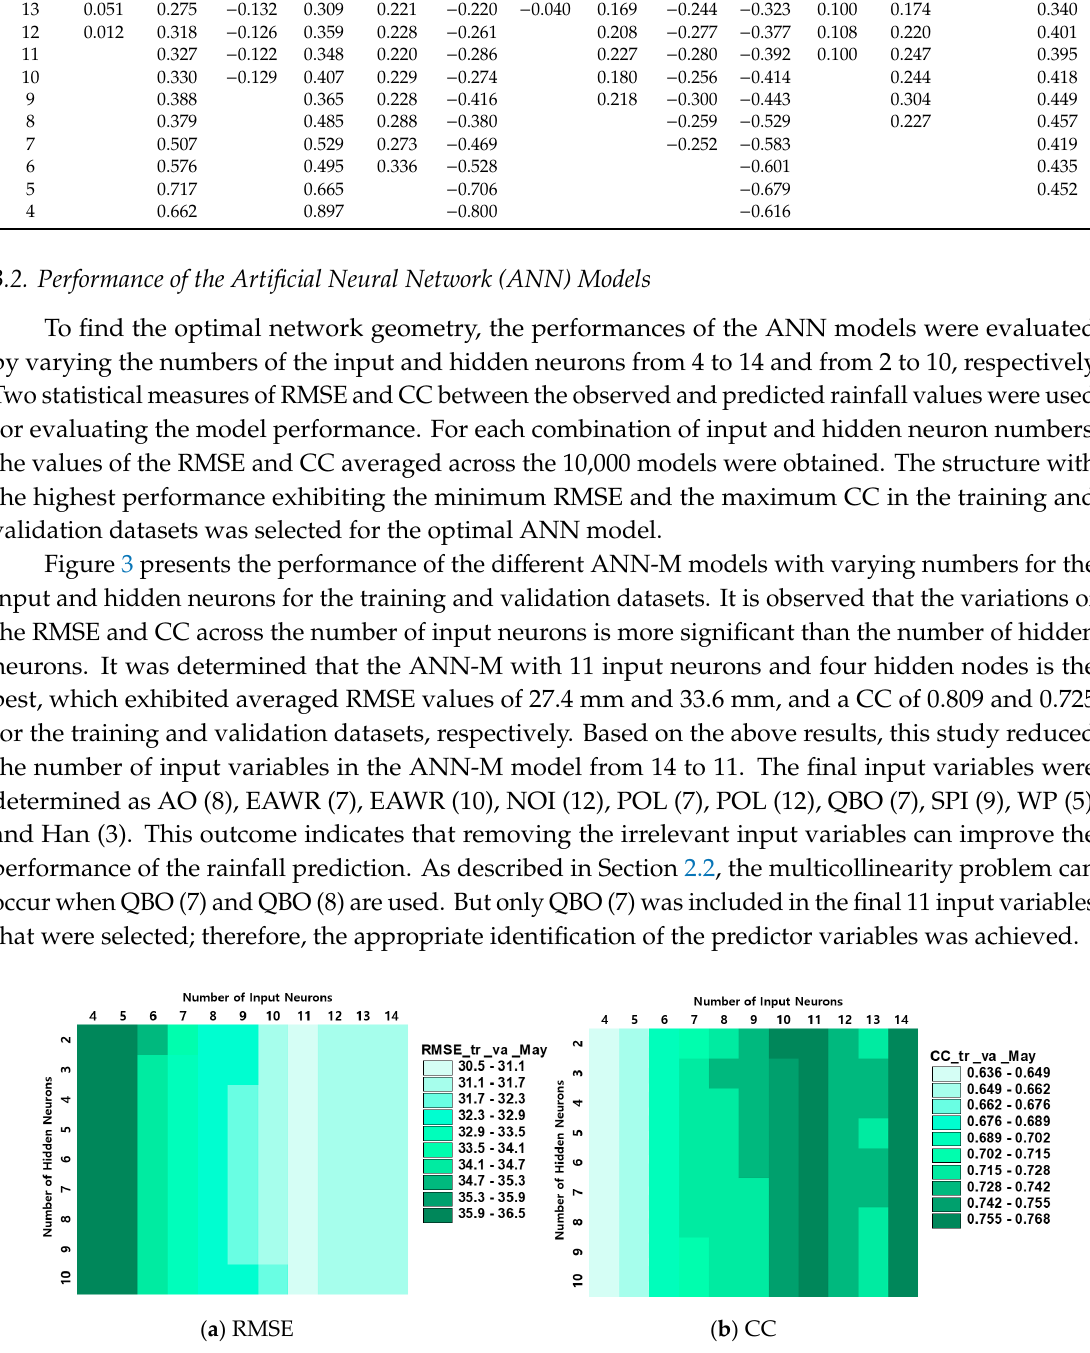
Figure 3. Performance of ANN-M model ( a ) root mean squared error ( b ) correlation coefficient.